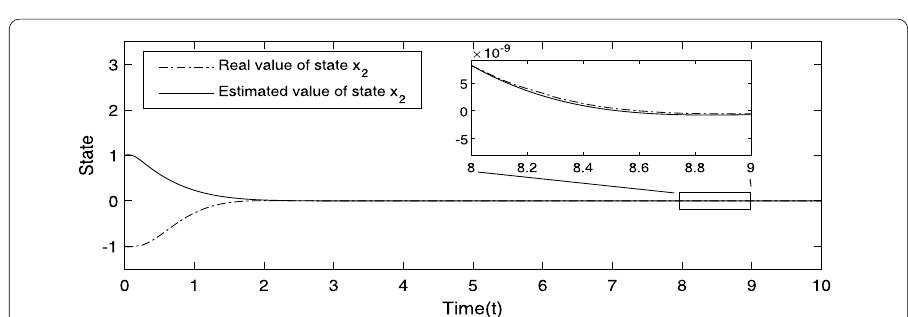
Figure 6 The simulation for state x 2 of the closed-loop systems with uncertainties